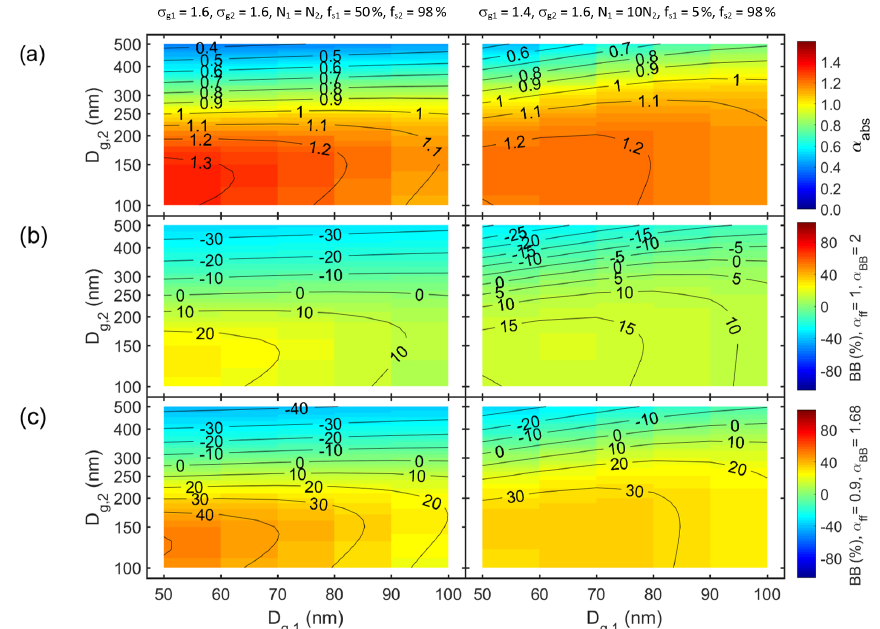
Figure 8. Bimodal particle size distributions with size-independent shell volume fractions f s in two modes as a function of geometric mean diameters of mode 1 ( D g1 ) and mode 2 ( D g2 ). (a) Absorption Ångström exponent ( α abs ) and the fraction of biomass-burning BC (BB(%)) calculated from it with the Aethalometer model constants of (b) α ff = 1 and α bb = 2 and (c) α ff = 0.9 and α bb = 1.68. The widths, the relative number of particles in the two modes, and the shell volume fractions of the two modes: σ g1 = 1.6, σ g2 = 1.6, N 1 = N 2 , f s1 = 50%, and f s2 = 98% on the left column and σ g1 = 1.4, σ g2 = 1.6, N 1 = 10 N 2 , f s1 = 5%, and f s2 = 98% on the right